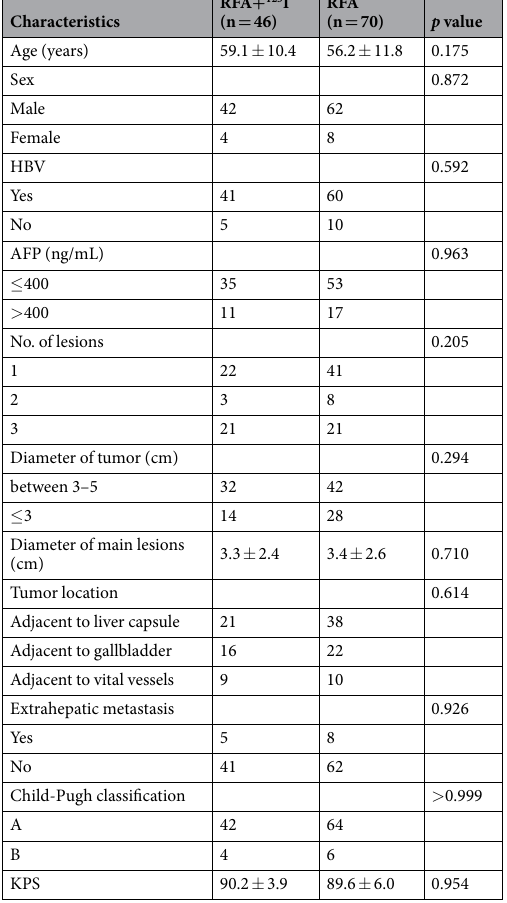
Table 1. Baseline characteristics of the 2 subgroups patients. HBV: hepatitis B virus; AFP: alpha-fetoprotein; KPS: karnofsky performance